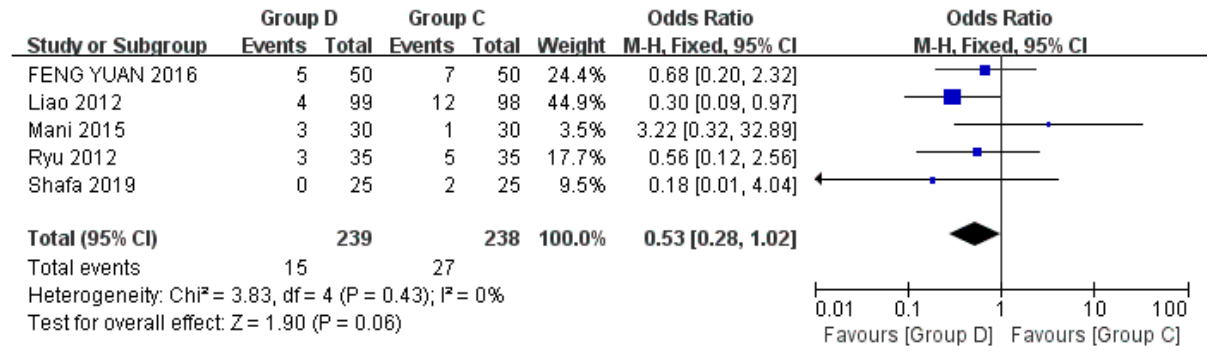
Figure 5. Forest plots comparing the effects of dexmedetomidine and control group on hypertension [22,24,27,29,32].